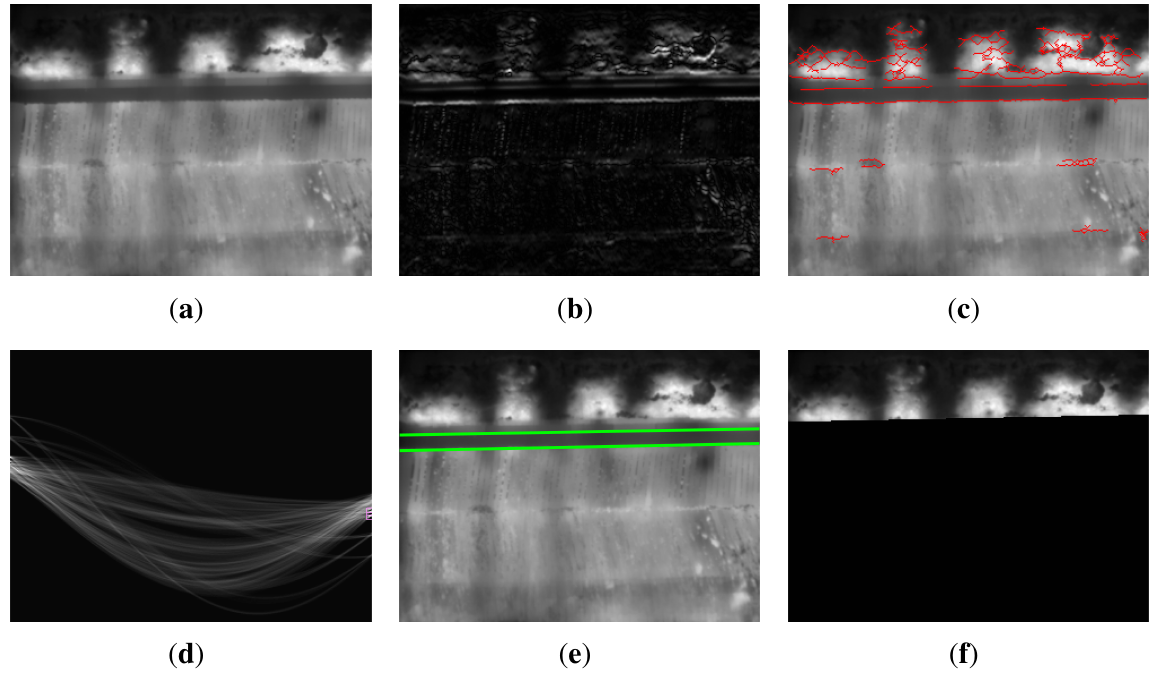
Figure 8. Detection of the regions of interest. ( a ) Key frame; ( b ) absolute value of the gradient; ( c ) edges after thresholding, thinning and opening; ( d ) Hough transform; ( e ) lines detected in the image; ( f ) final region of interest after removing the unwanted